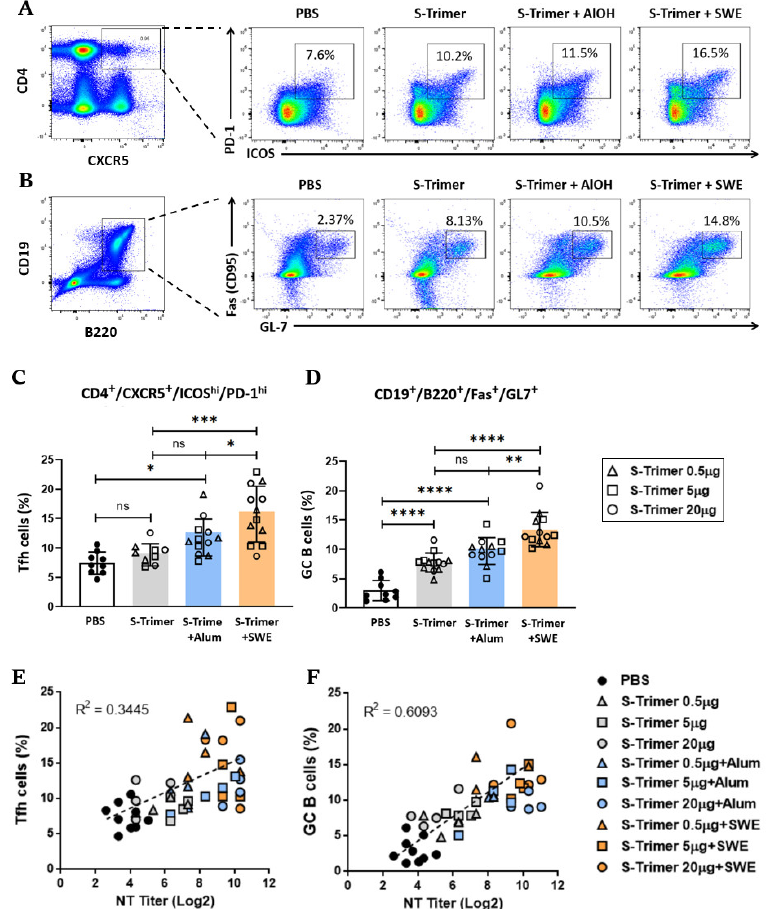
Figure 4. Increased number of Tfh and GC B cells in dLNs from vaccinated BALB/c mice. BALB/c mice ( n = 3–4/group) were administered PBS as a control or 0.5 µ g or 5 µ g or 20 µ g of S-Trimer protein with or without adjuvant (Alum or SWE) via intramuscular (IM) injection twice on Day 0 and 28. The dLNs were analyzed by flow cytometry at two weeks after the second vaccination. Representative dot plots of lymphocytes from immunized mice and gated on ( A ) CD4 + CXCR5 + ICOS high PD1 high Tfh cells and ( B ) CD19 + B220 + GL-7 + Fas + (CD95) GC B cells and percentage of ( C ) Tfh cells and ( D ) GC B cells in dLNs. Correlations between neutralization titer and percent of ( E ) Tfh cells or ( F ) GC B cells for each mouse. Symbols represent individual mice; bars indicate mean ± SD percentage of cells. Statistical analysis of comparisons among groups was made by two-tailed Mann–Whitney tests. * p < 0.05, ** p < 0.008, *** p < 0.0005, **** p < 0.0001; ns: not significant. The Spearman rank test was used to perform correlation analysis.